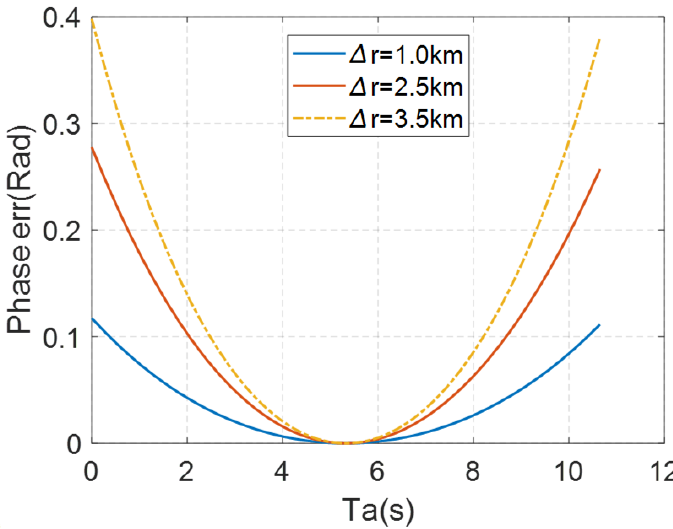
Figure 8. Phase error caused by ignoring the range variation of high-order